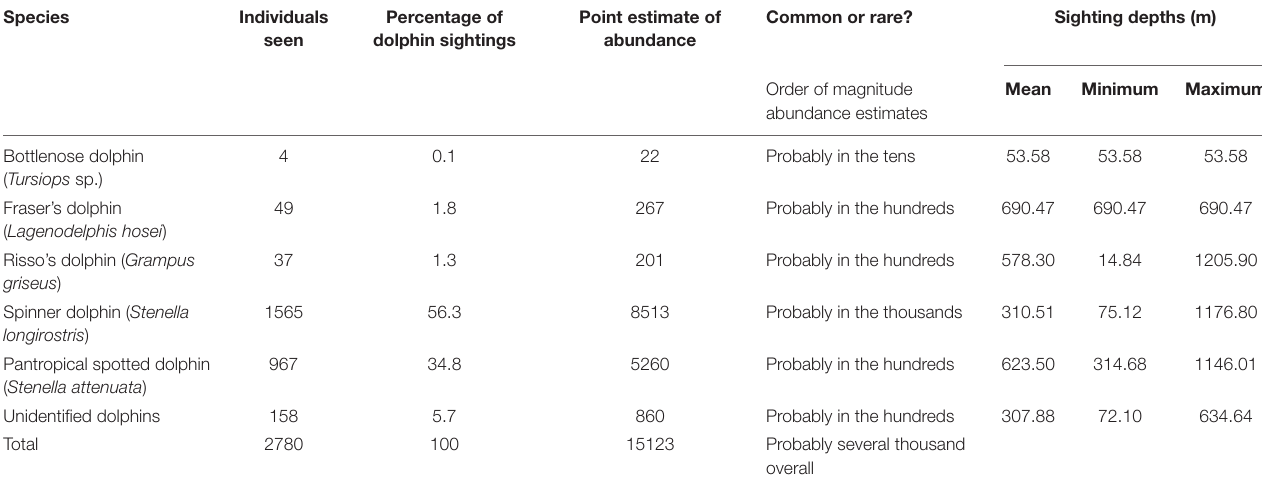
Percentage of Point estimate of Common or rare? Sighting depths (m) seen dolphin sightings abundance Order of magnitude Mean Minimum Maximum abundance estimates